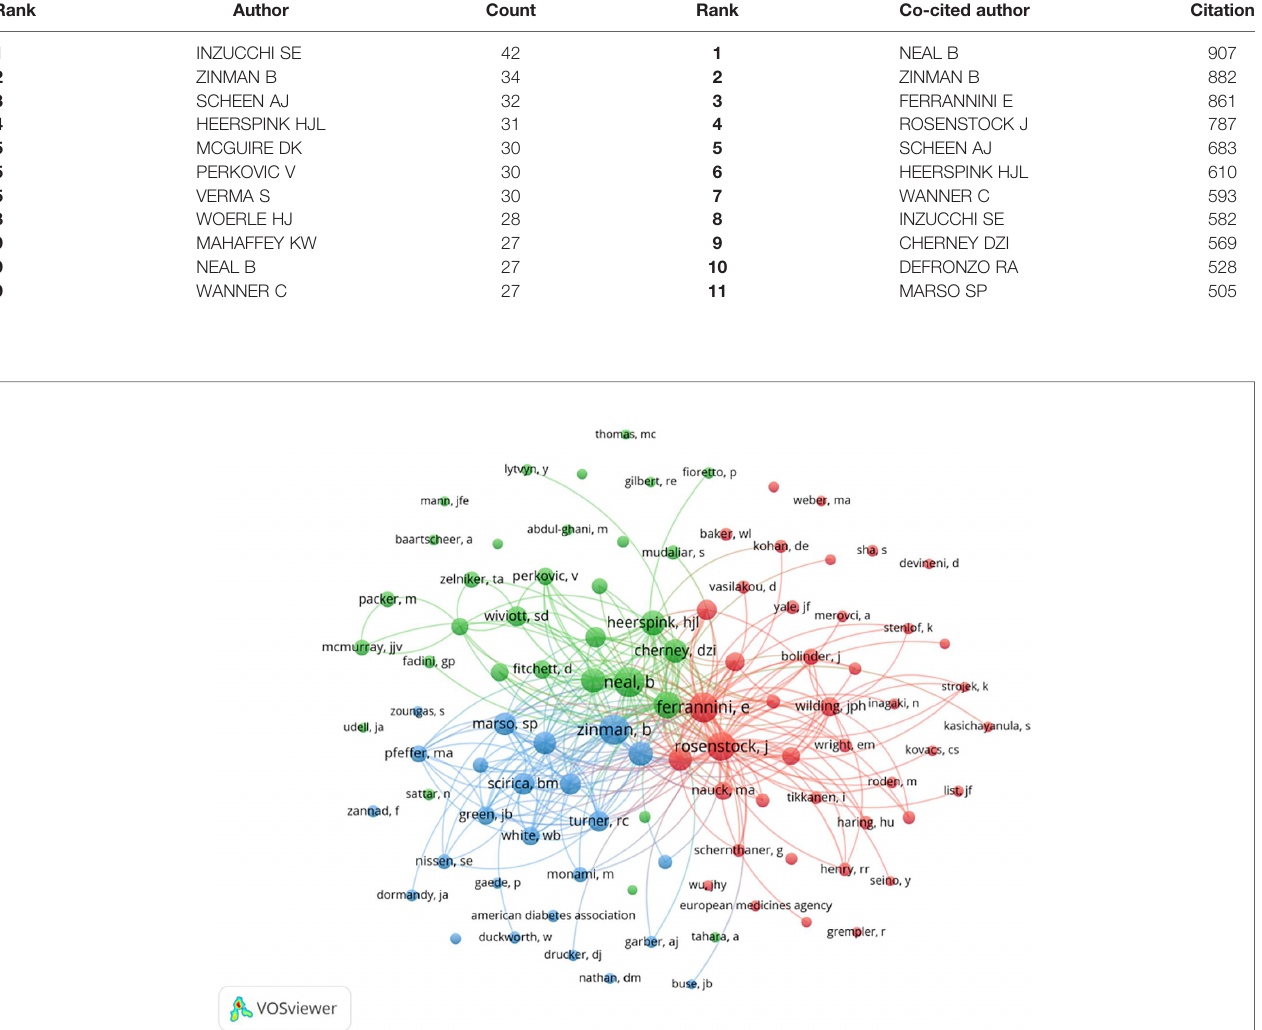
FIGURE 3 | VOSviewer network visualization map of cocited authors of the articles related to SGLT2 inhibitors in cardiovascular research. Of the 23,266 cocited authors, 99 had at least 100